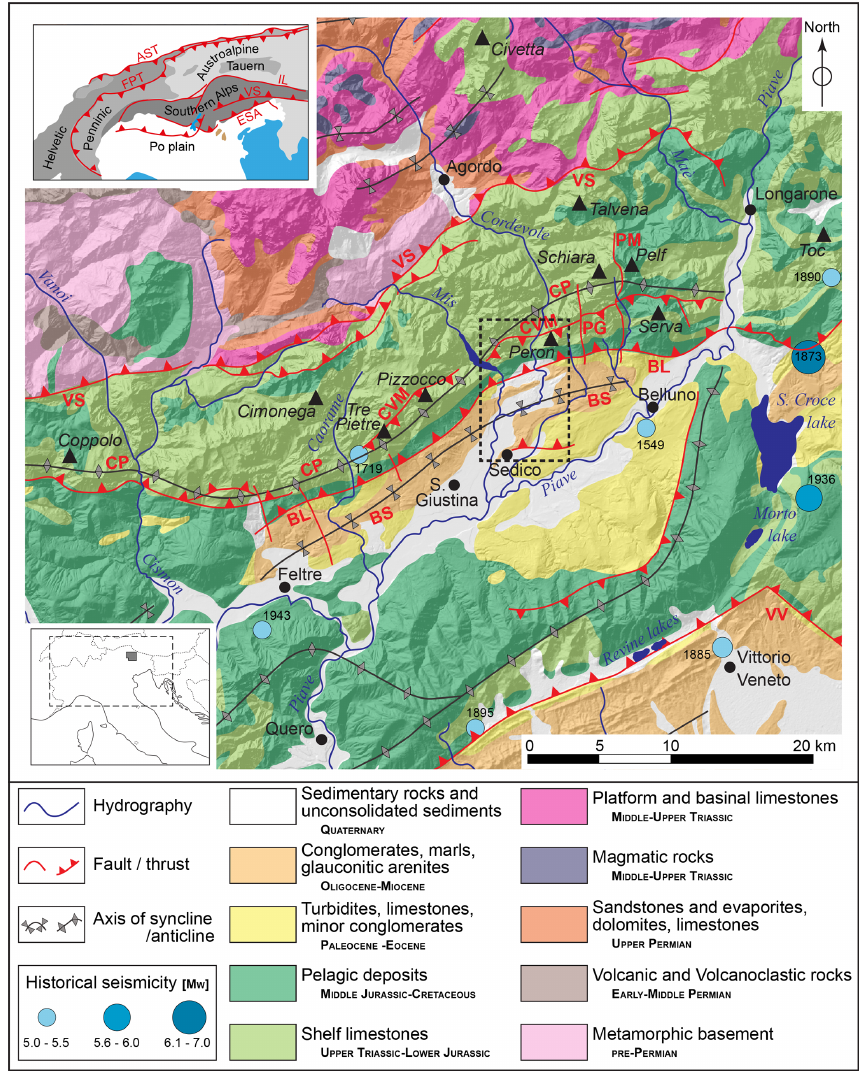
Figure 1. Simplified regional geological map (black dashed-line box indicates location of Fig. 3). The map is based on Bosellini et al. (1981), Masetti and Bianchin (1987), Bigi et al. (1990), and Costa et al. (1996). Epicentres of earthquakes from the last 2 millennia are shown with colour coding and year of occurrence (source: Parametric Catalogue of Italian Earthquakes, 2015 version Rovida et al., 2016). The base map is the SRTM-derived digital elevation model (30m cells) (source: http://viewfinderpanoramas.org/, last access: 17 October 2019). The structural setting is shown in the upper left inset (based on Doglioni, 1990). AST: Alpine Sole thrust; BL: Belluno thrust; BS: Belluno syncline; CP: Coppolo-Pelf anticline; CVM: Val Carpenada–Val di Vido–Val Madonuta thrust; ESA: eastern Southern Alps thrust system; FPT: frontal Penninic thrust; IL: Insubric line; PG: Pala Alta–Gresal; PM: Pala Bassa–Val Medone; VS: Valsugana thrust; VV: Vittorio Veneto